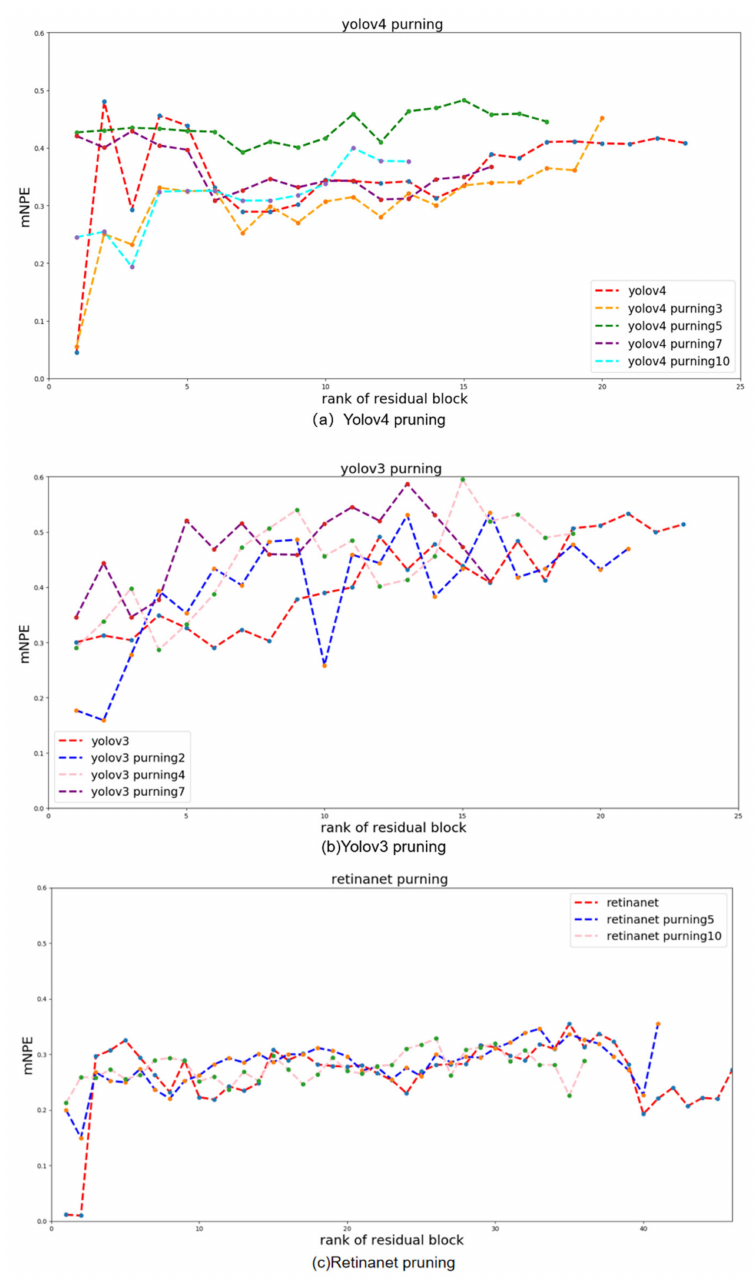
Figure 6. The pruning process, with the horizontal coordinates of the residual block number and the vertical coordinates of the overall evaluation index of the residual block. Figure ( a ) shows the pruning process of yolov4, Figure ( b ) shows the pruning process of retinanet, Figure ( c ) shows the pruning process of